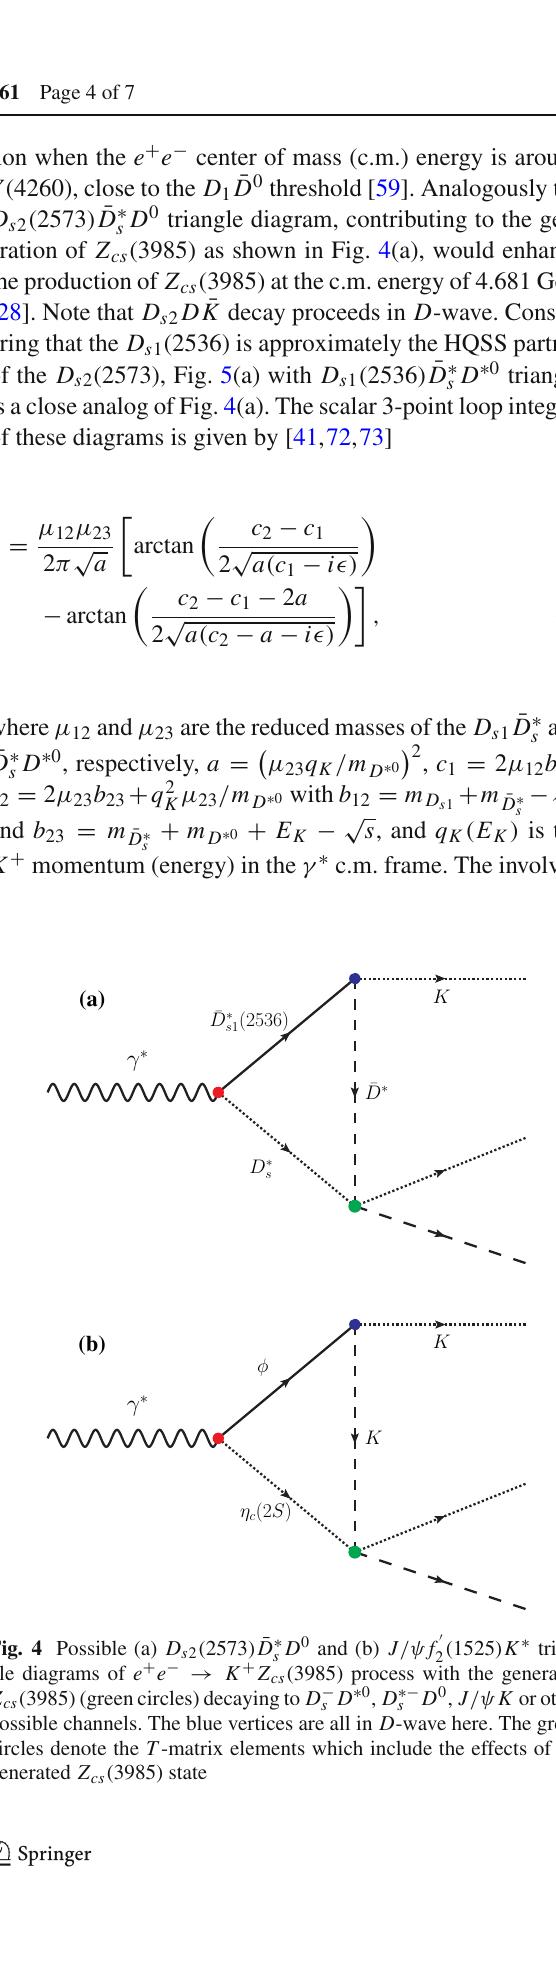
Fig. 4 Possible (a) D s 2 ( 2573 ) ¯ D ∗ s D 0 and (b) J /ψ f (cid:5) gle diagrams of e + e − → K + Z cs (3985) process with the generated Z cs (3985) (green circles) decaying to D − s D ∗ 0 , D ∗− s D 0 , J /ψ K or other possible channels. The blue vertices are all in D -wave here. The green circles denote the T -matrix elements which include the effects of the generated Z cs (3985) state